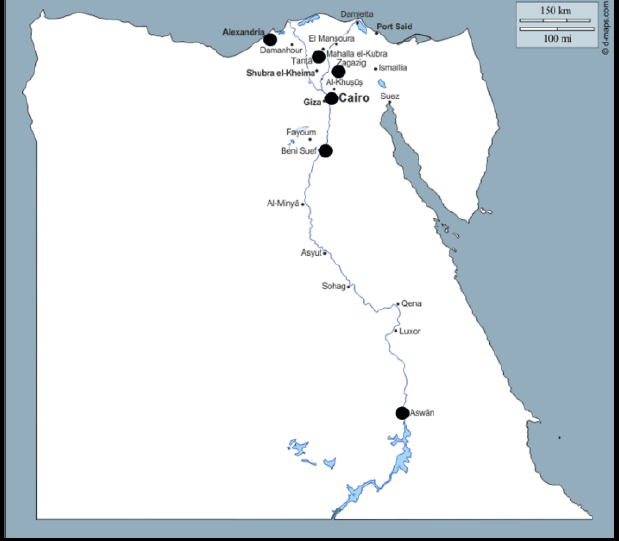
Figure 1: Geographical distribution of the six participating cancer care facilities (Map available from: https://d-maps.com/carte.php?num_car=34800&lang=en) Oncologists from the selected six centers were invited to take part in the study and they consented to participate by completing the